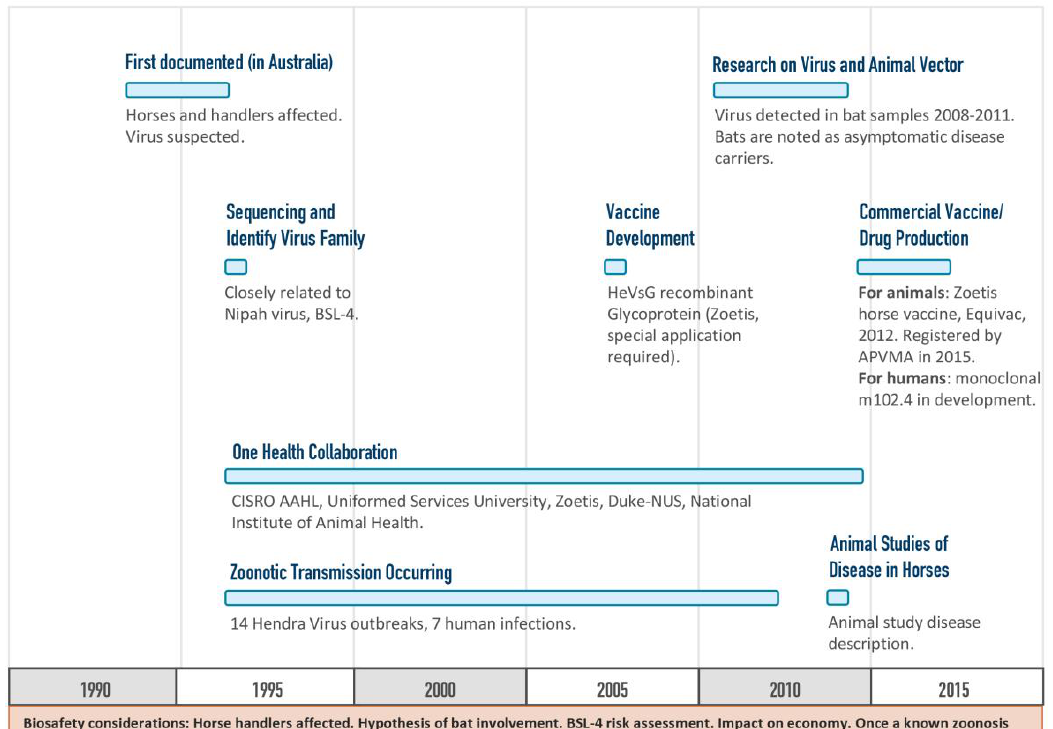
Figure 5. Timeline of the research and development of the Hendra virus vaccine. This timeline shows highlights from the initial Hendra virus disease discovery to the licensure of a vaccine for livestock [4,15,17].